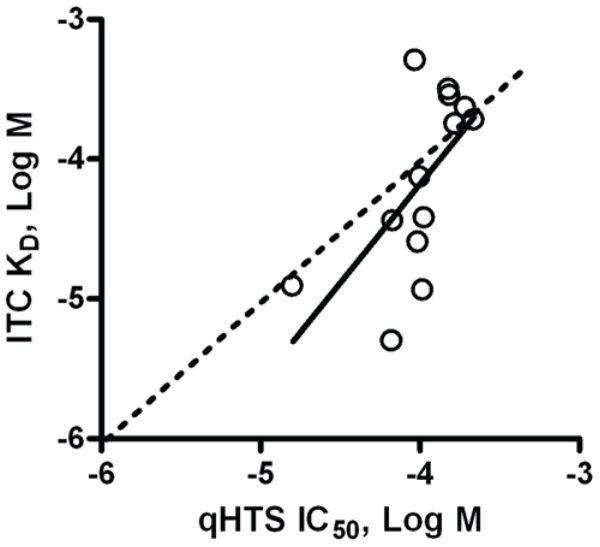
Figure 7. Relationship between qHTS IC 50 and ITC K D . Shown are 13 compounds for which ITC experiments provided reliable parameters, together with the fit (solid line, R 2 =0.4; P=0.02) and the line of identity (dotted).